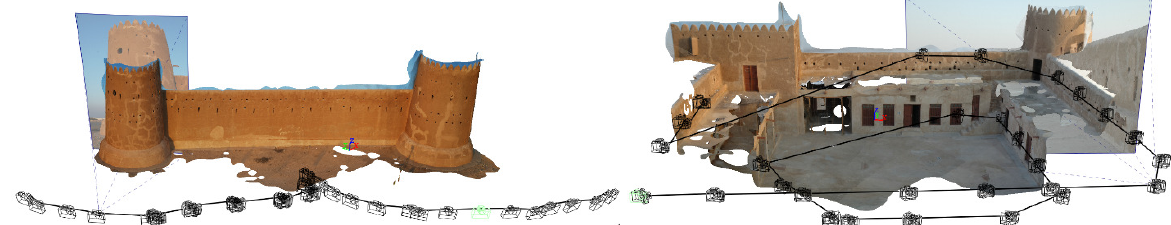
Figure 7: Example for camera positions at Al Zubarah fortress – western exterior wall (left) and southern interior façade (right)